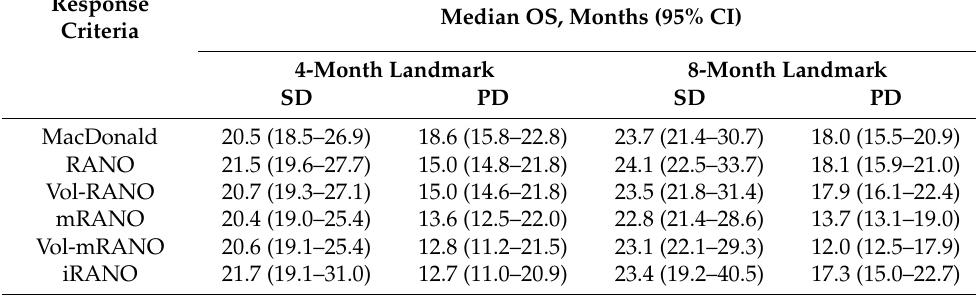
Table 6. Impact of stable disease or progressive disease on median overall survival at 4- and 8-month landmark time with corresponding confidence